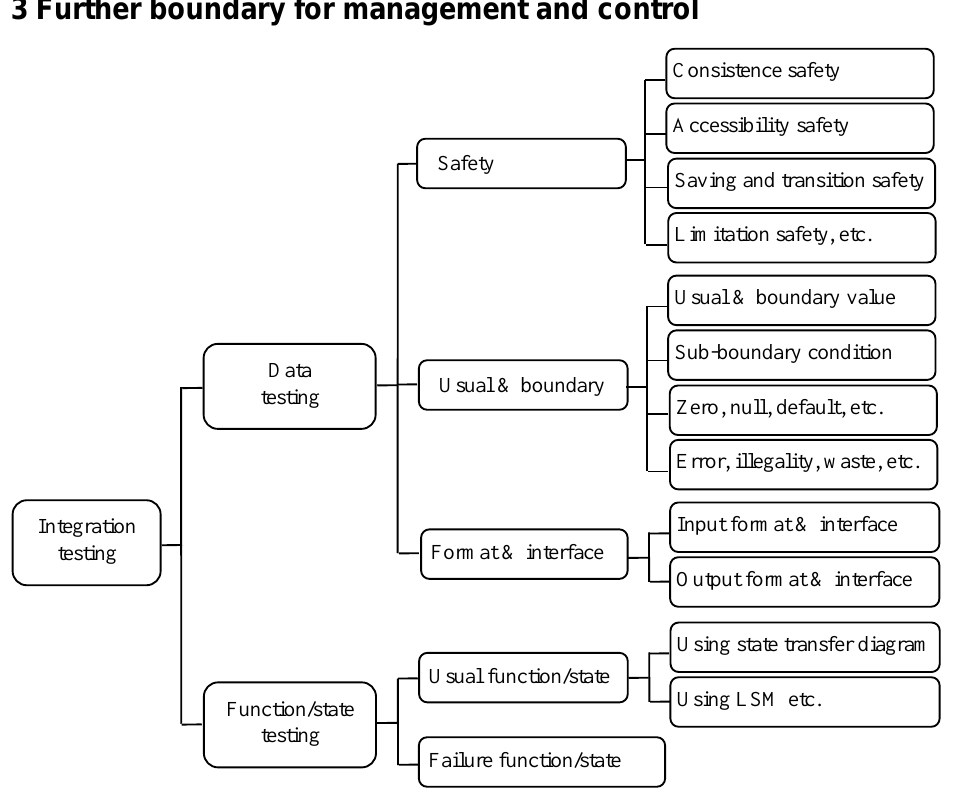
Fig. 2. Typical contents of integration testing